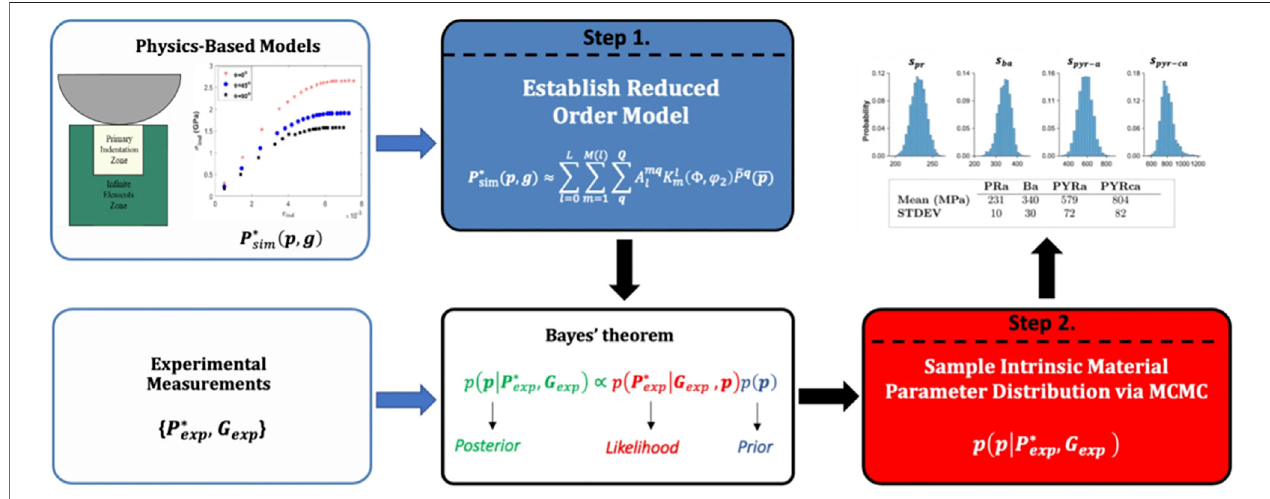
FIGURE 6 | An example application of the Bayesian update strategy for the fusion of experimental and simulation datasets from indentation of a-Ti grains in a polycrystalline sample (Castillo et al., 2021).